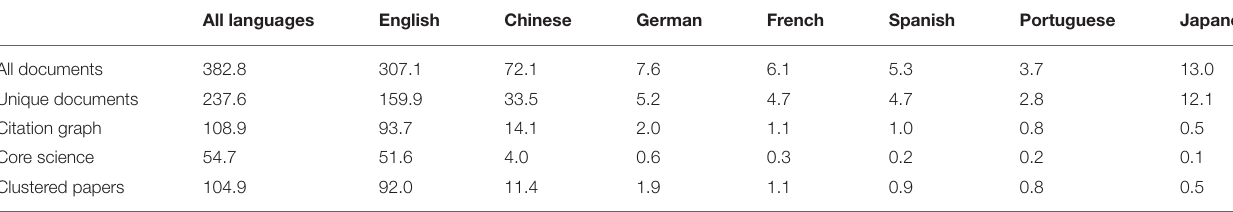
TABLE 1 | Breakdown of document counts by languages (in millions), language labels are